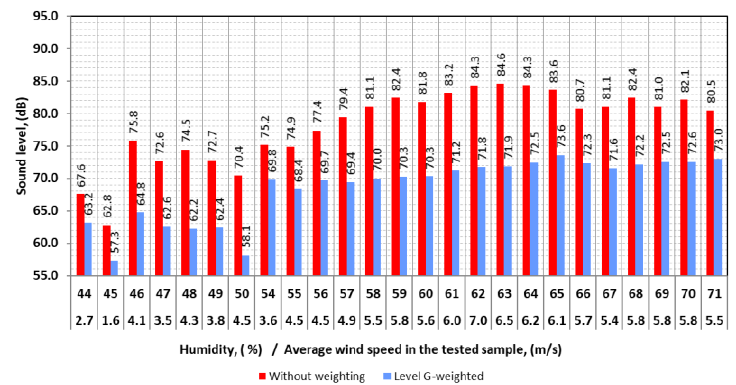
Figure 15. Variations in noise level in the function of air humidity—T2 turbine.